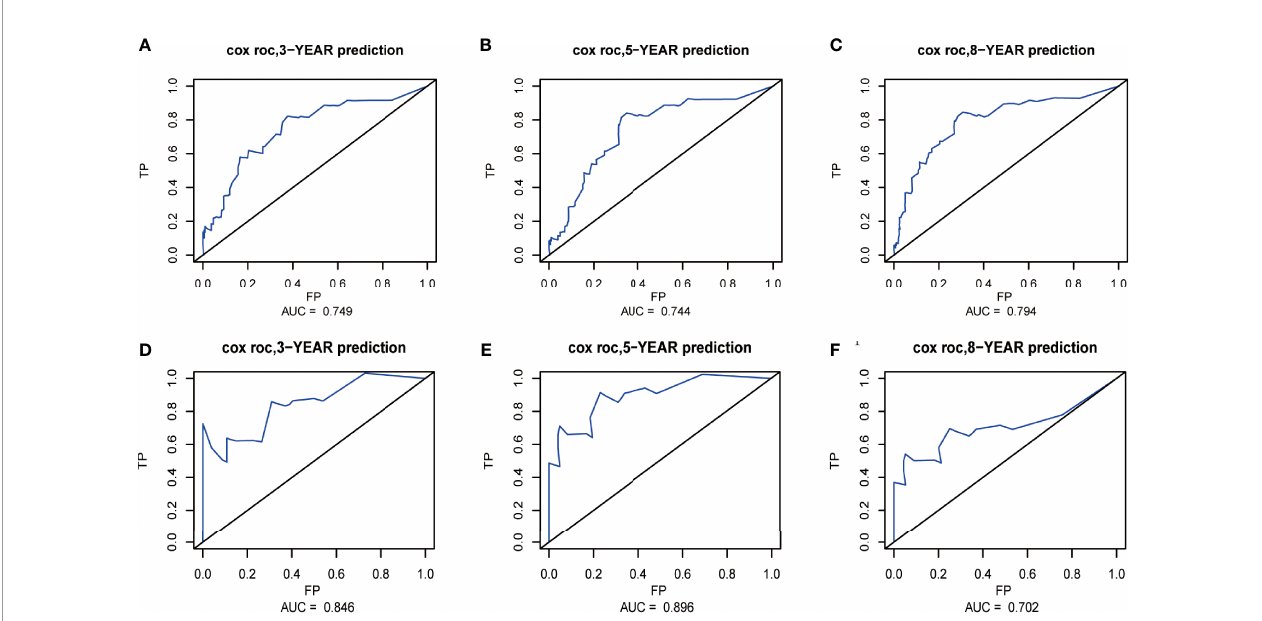
FIGURE 4 | Receiver operating characteristic (ROC) curves at 3, 5, and 8 years in the training set (A – C) and validation set (D – F) for validating the overall survival (OS) prediction